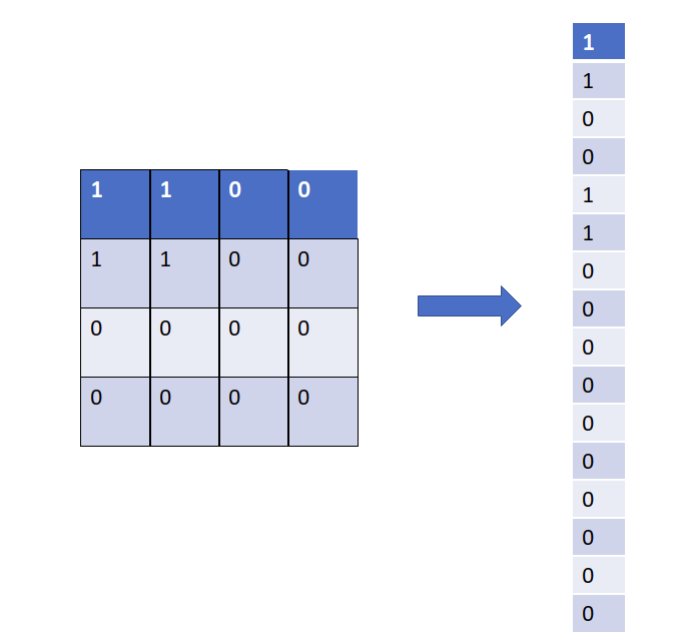
Figure 8. Transformation of the output matrix into a vector using flattening by recovering the pixels line by line and adding them to the final